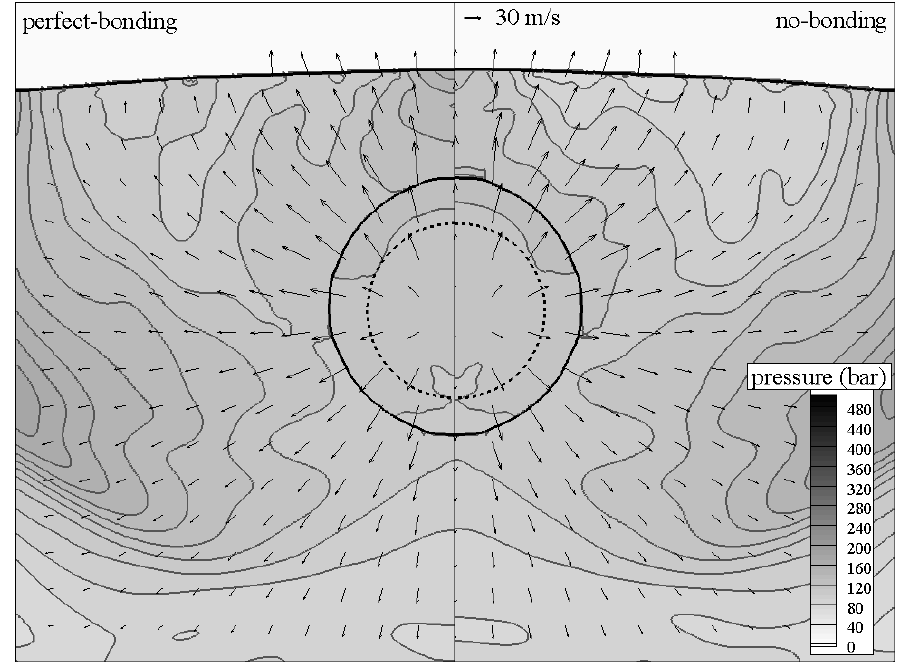
Fig. 13. Comparison of the fluid fields at t = 1 . 5 ms between the perfect- and no-bonding sandwich plates with clamped ends.